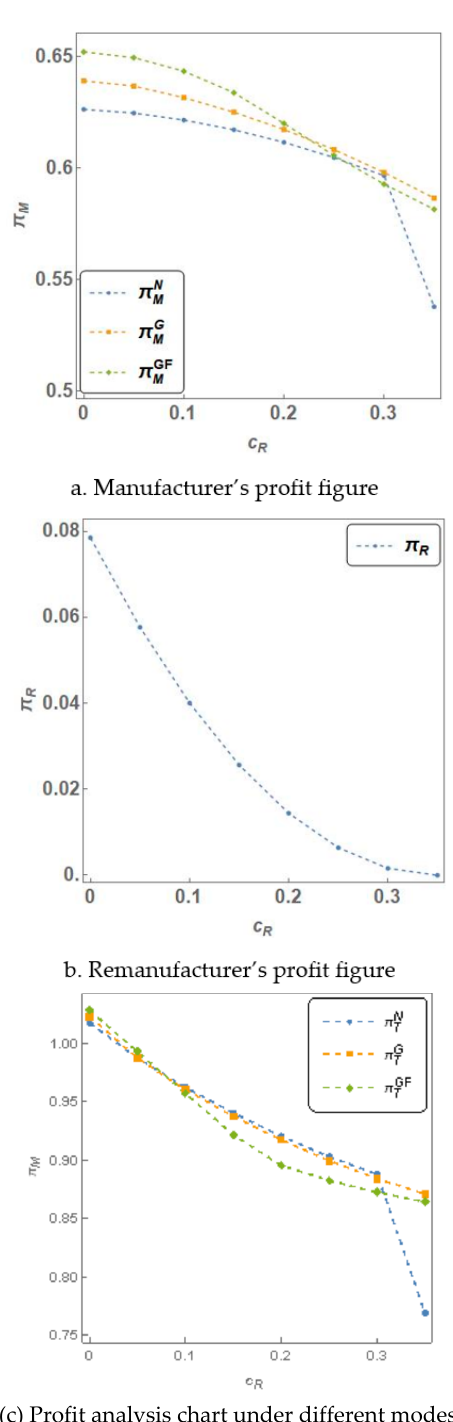
Figure 4. Profit figures under di ff erent models. ( a ) Manufacturer’s profit figure; ( b )Remanufacturer’s profit figure; ( c ) Profit analysis chart under di ff erent